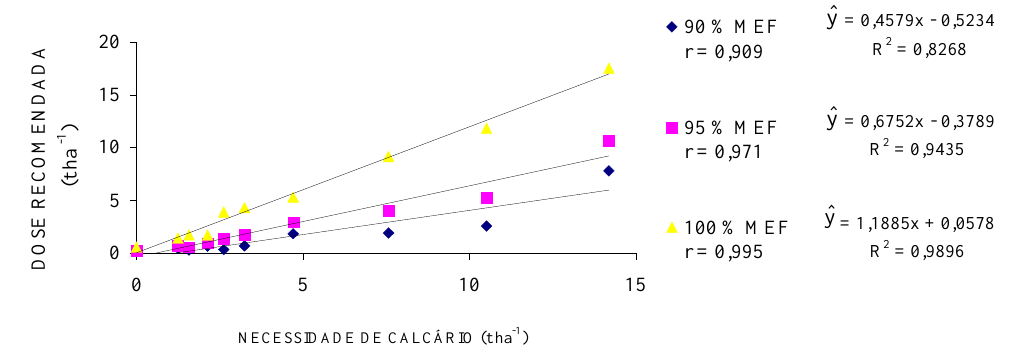
Figura 6. Relação entre as necessidades de calcário, pelo método que considera a saturação por bases para elevar V a 70%, e as doses recomendadas de calcário para obtenção de 100, 95 e 90% da máxiam eficiência física (MEF).